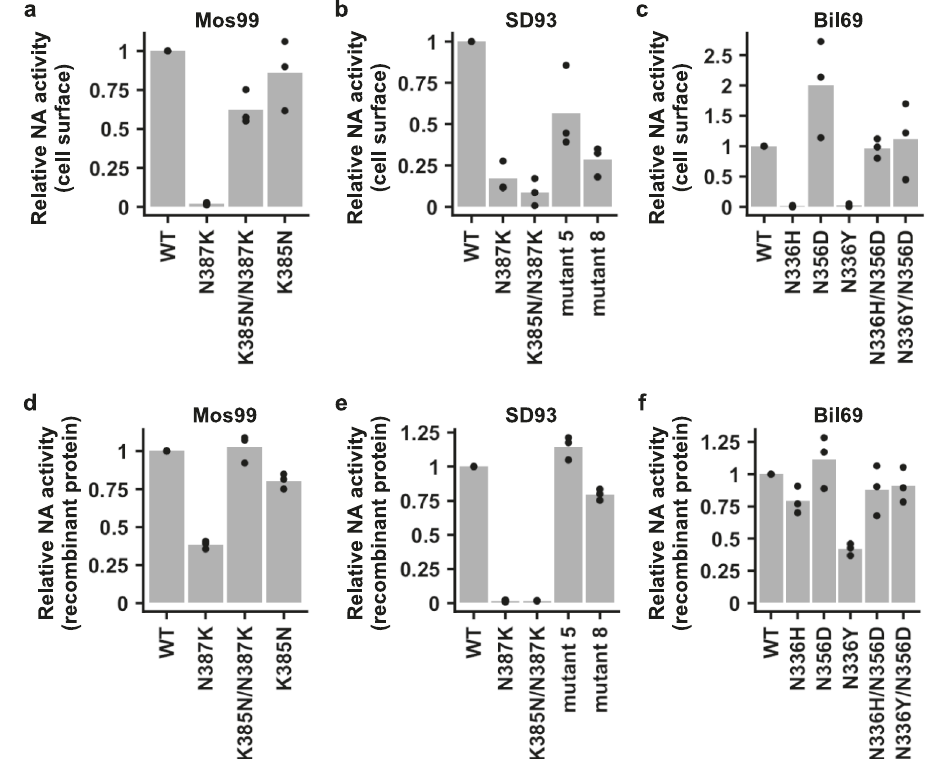
Fig. 4 | Functional characterization of different NA mutants. a – c Relative cell surface NA activity of a Mos99 mutants, b SD93 mutants, and c Bil69 mutants. d – f Relative NA activity of recombinant proteins of d Mos99 mutants, e SD93 mutants, and f Bil69 mutants. Each bar represents the mean of three independent